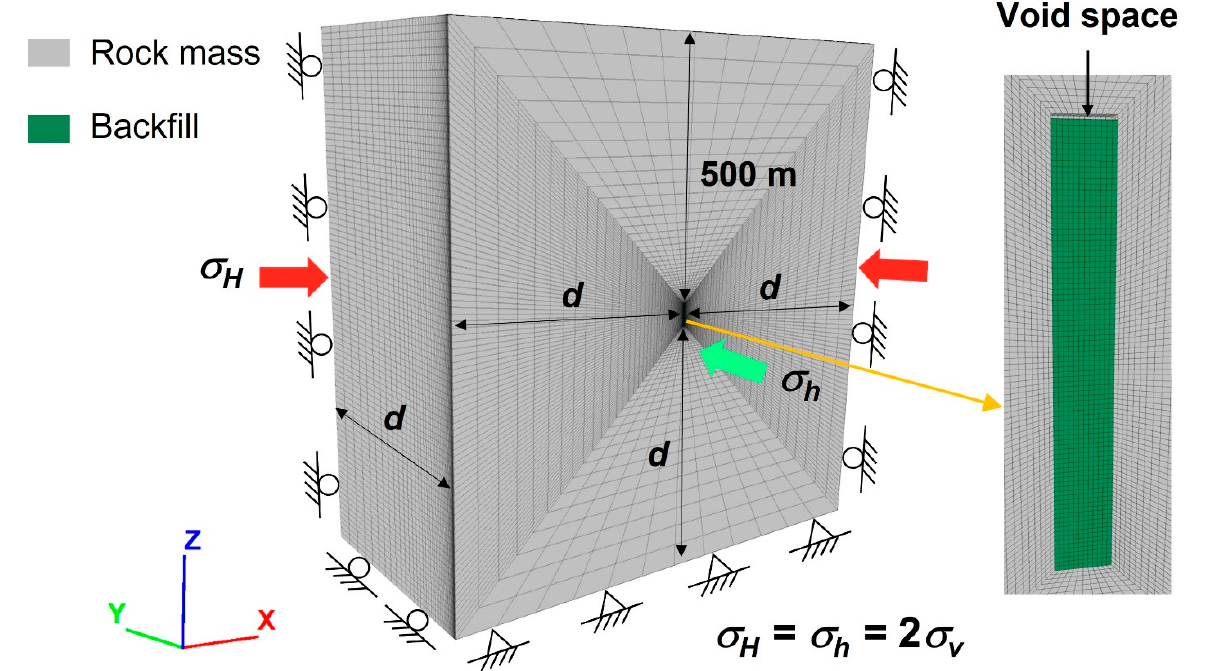
Figure 14. The numerical FLAC3D model of the three-dimensional vertical backfilled stope in an elastic rock mass.